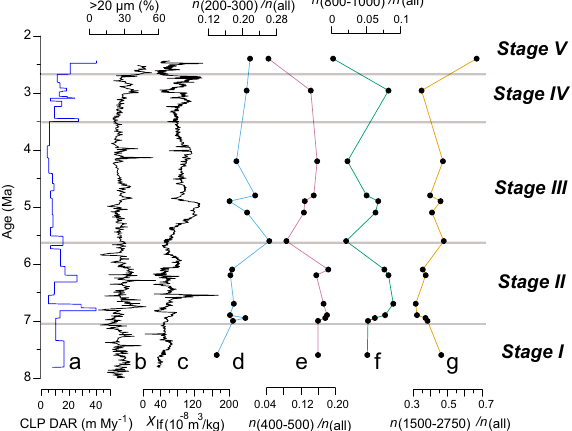
Fig. 3 JX dust accumulation rate, grain size, magnetic susceptibility, and contribution variations of different zircon U-Pb age populations. a Dust accumulation rate (this study). b >20 μ m percentage of all clastic noncarbonate grains (data from Ref. 56 ). c Magnetic susceptibility record (this study). d The number of zircon ages within the 200 – 300 Ma range over all zircon ages [n(200 – 300 Ma)/n(all)] (this study). e The number of zircon ages within the 400 – 500 Ma range over all zircon ages [n(400 – 500 Ma)/n(all)] (this study). f The number of zircon ages within the 800 – 1000 Ma range over all zircon ages [n(800 – 1000 Ma)/n(all)] (this study). g The number of zircon ages within the 1500 – 2750 Ma range over all zircon ages [n(1500 – 2750 Ma)/n(all)] (this study). The gray bars indicate stage divisions mentioned in the